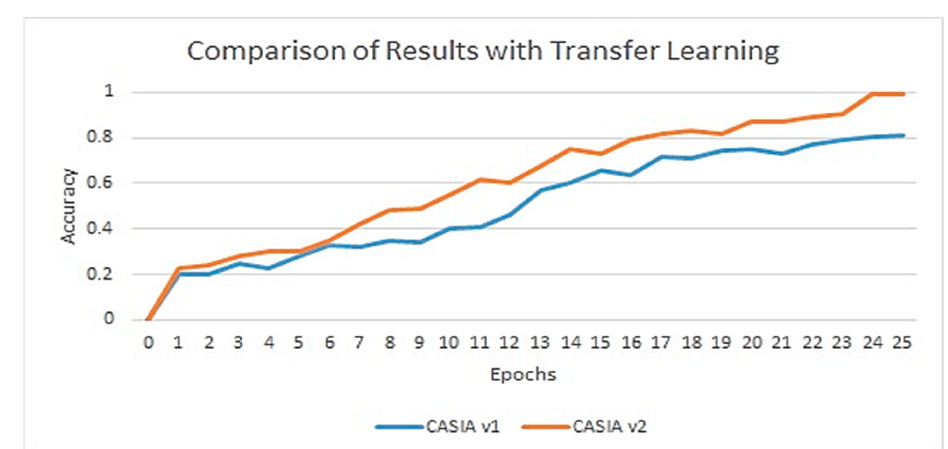
Figure 10. Testing process visualization with transfer learning.